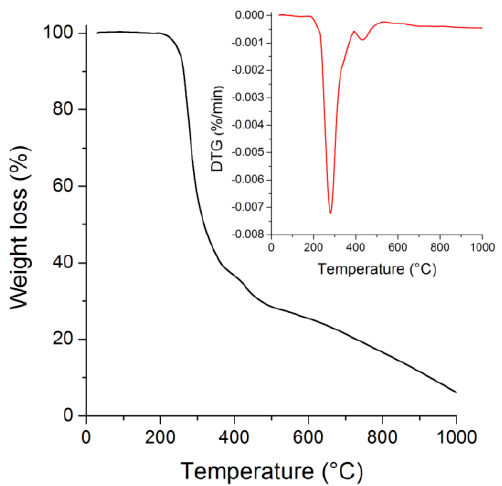
Figure 2. Thermogravimetric analysis plot of compound 7 at 10 ◦ C · min − 1 . The inset shows the respective derivative thermogravimetric curve.